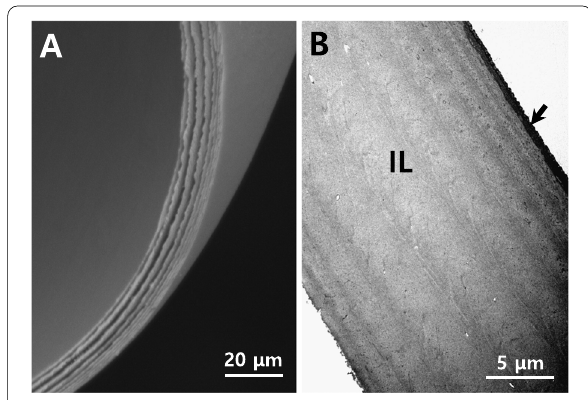
Fig. 4 Electron micrographs of cross section of the fertilized egg envelopes. The fertilized egg envelope had a lamellar layered structure under the scanning electron microscope ( A ) and the fertilized egg envelope consists of two layers, an outer electron dense layer (arrow) and an inner lamellar layer (IL) comprising of 10 sublayers of varying thicknesses under the transmission electron microscope ( B